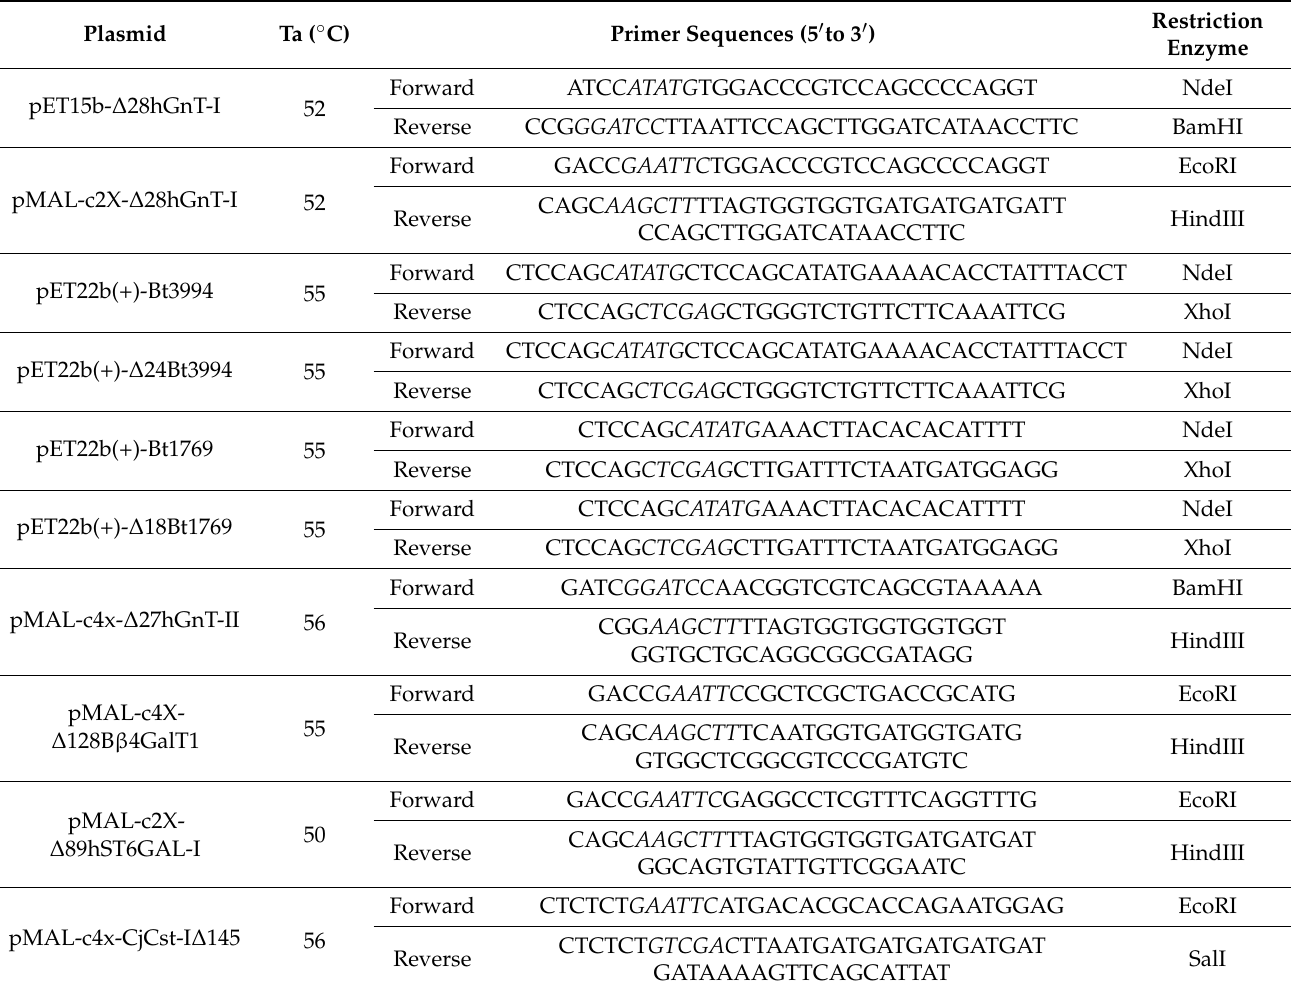
Table 2. Primers used for cloning. Restriction sites are